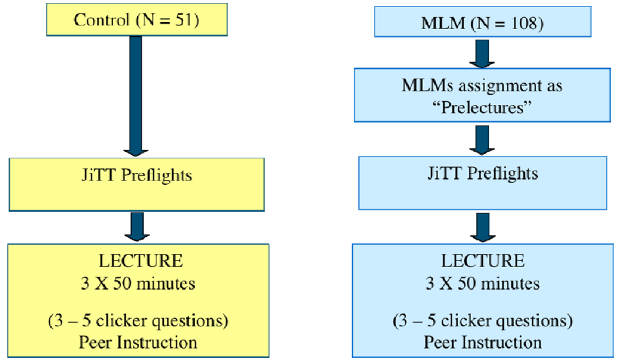
FIG. 1 (color online). A schematic representation of the con- trolled study design. The students in the MLM group viewed an average of two MLMs per week, a total of 17 during the quarter.